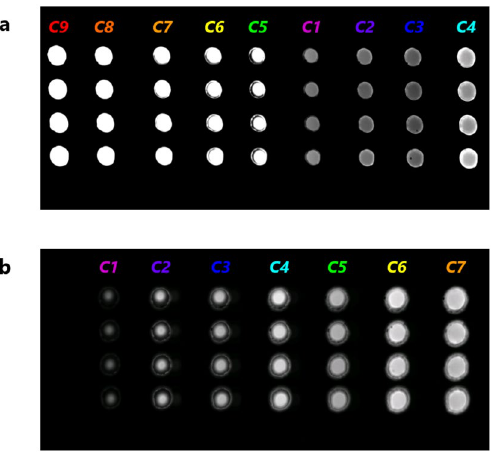
Figure 5. Comparison of qualities of split images formed by the conventional and novel spectrometers. ( a ) Four sets of nine-color split images ( C1 − C9 ) formed by the novel nine-color spectrometer. ( b ) Four sets of seven- color split images ( C1 − C7 ) formed by the conventional seven-color spectrometer. Fluxes ( C0 ) with wavelength of 400 to 750 nm from four emission points were respectively collimated and incident on each